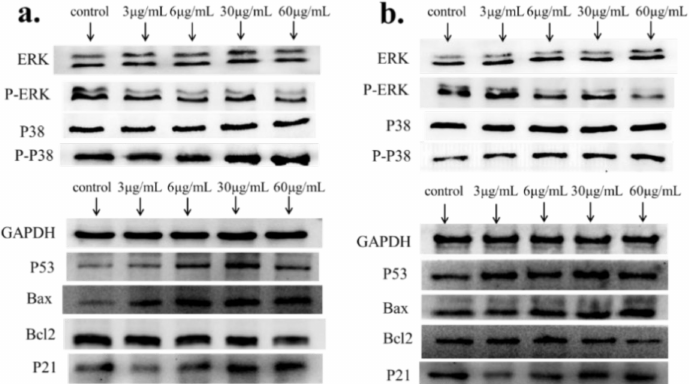
Figure 5. Western-blot analysis of the expression changes in protein level of P53, Bax, Bcl-2, P21 after exposure to Ag NPs for HCT116 and NCM460 cells. ( a ) HCT116 cell protein expression result; ( b ) NCM460 cell protein expression